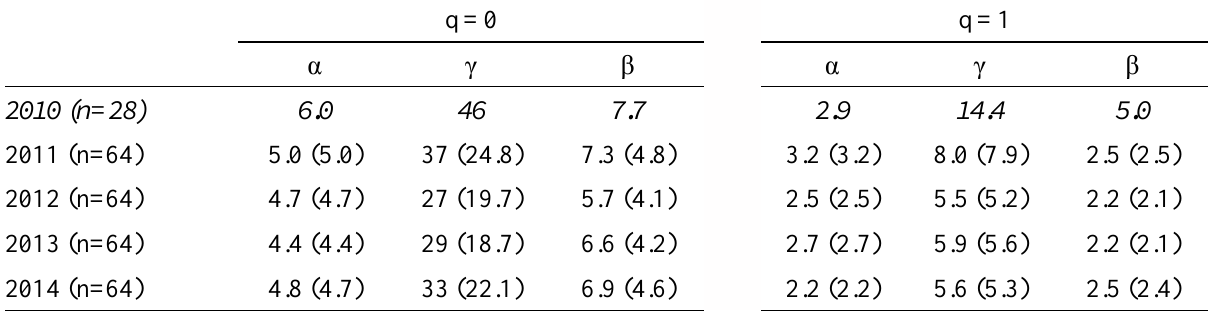
Table 1. Development of alpha-, gamma- and beta diversity (Hill numbers) with respect to sampling data from 2010 to 2014. The weighting factor q determines how species abundances are taken into account (q = 0 yielding species richness). Note that the 2010 data were not acquired within this study. Numbers in brackets represent results after averaging 100 random subsamples of the 2011–2014 datasets to the number of plots in the 2010